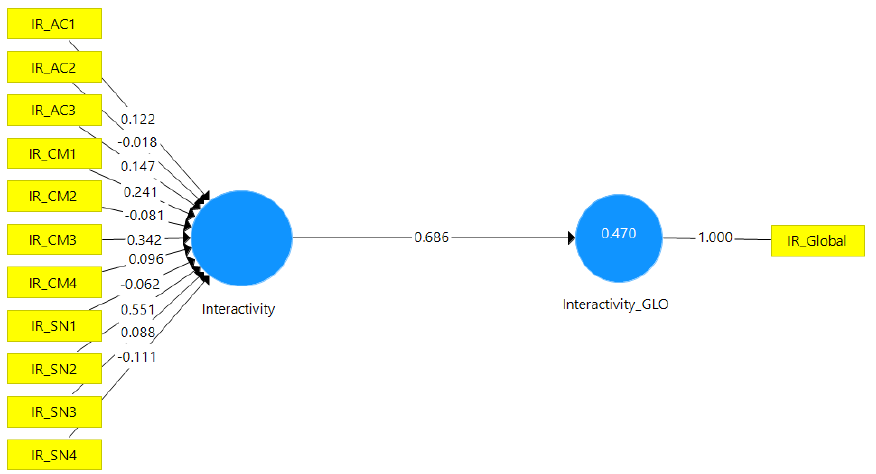
Figure 1. Formative Construct’s Convergent Validity. Figure 2. Formative Construct’s Convergent Validity.